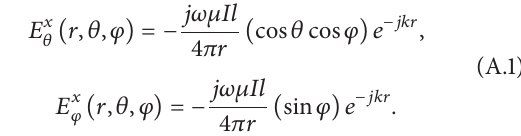
of [1, 12] which are exclusively valid only for the far